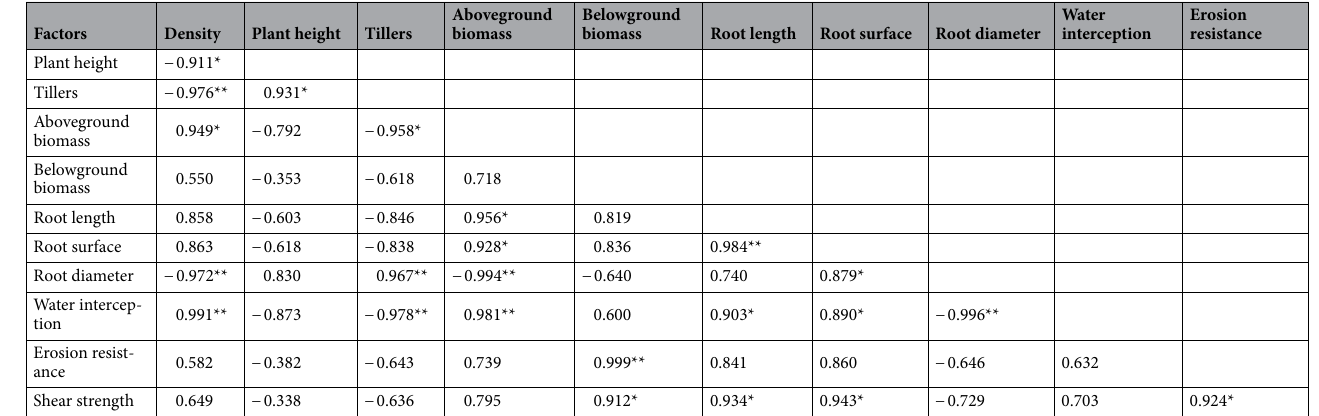
Table 2. Correlations among sowing density and physiological indicators of E. nutans. *Significantly correlated at the 0.05 level (two-sided); **significantly correlated at the 0.01 level